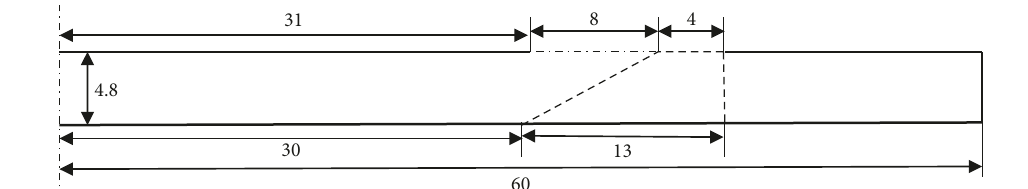
Figure 3: Half of the longitudinal sectional dimension of the subway platform (unit: m).